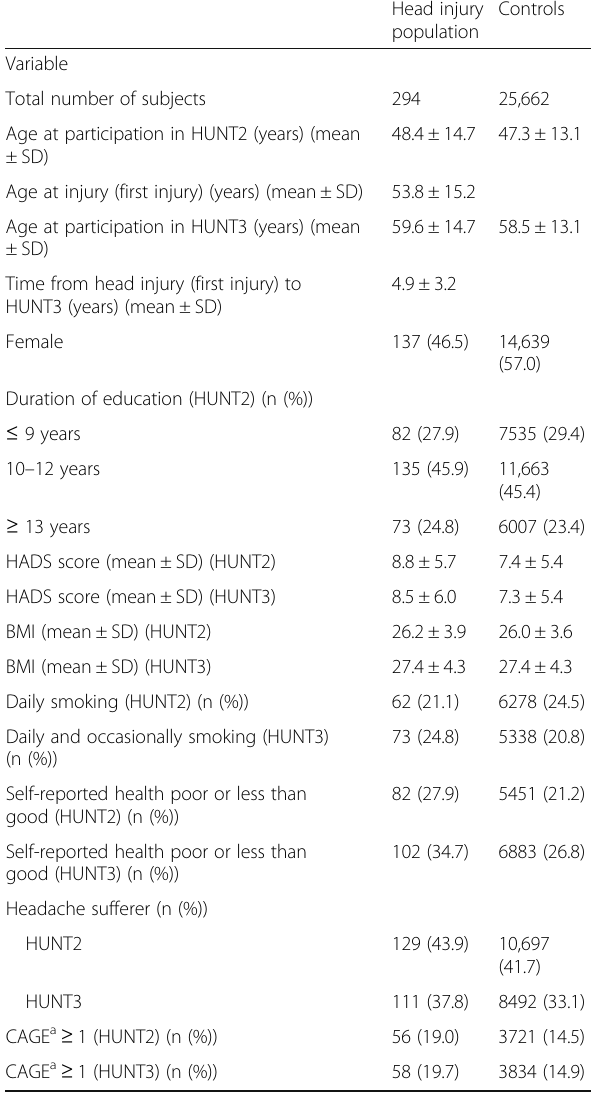
Table 1 Demographics and health related variables